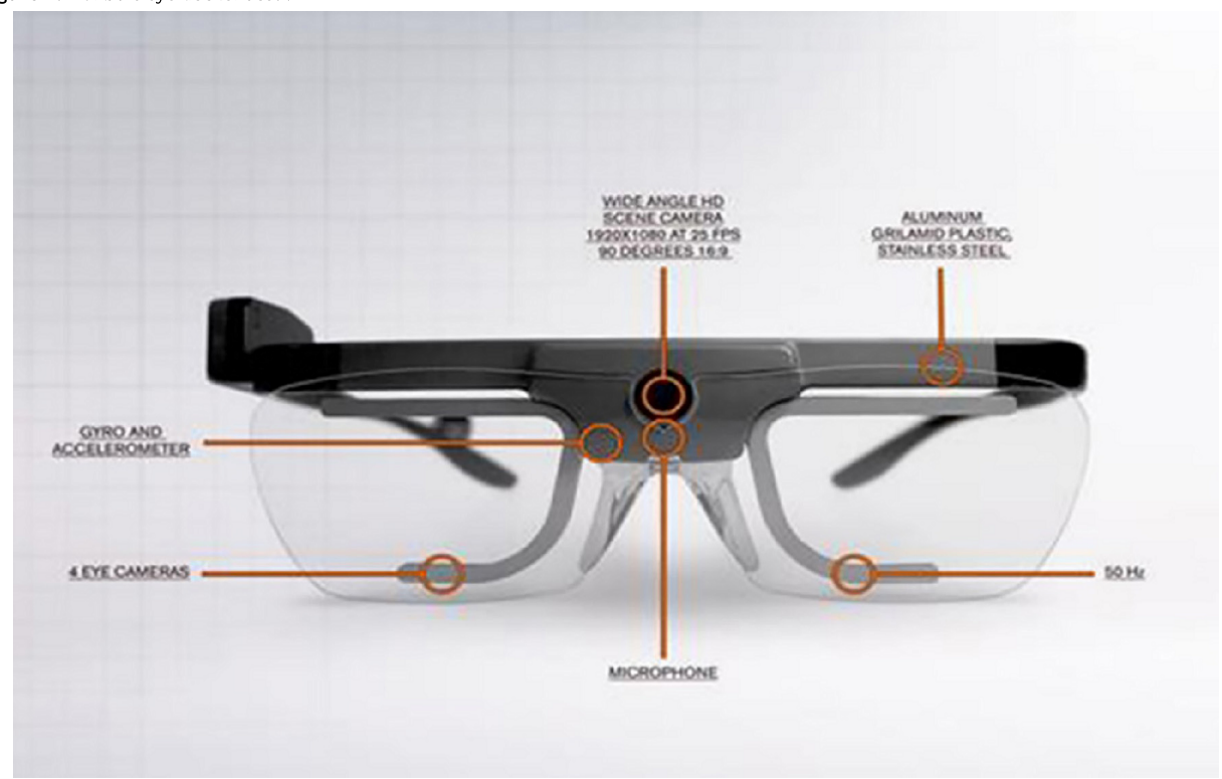
Figure 1. Portable eye tracker